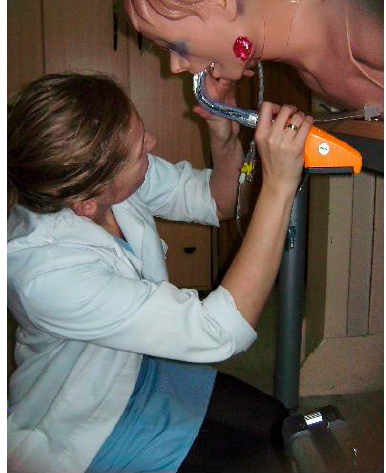
Figure 4. Intubation of a trauma manikin in a prone position (Author`s own material).